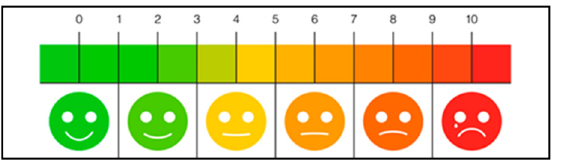
Figure 4. VAS applied in order to assess the workers’ perceptions about